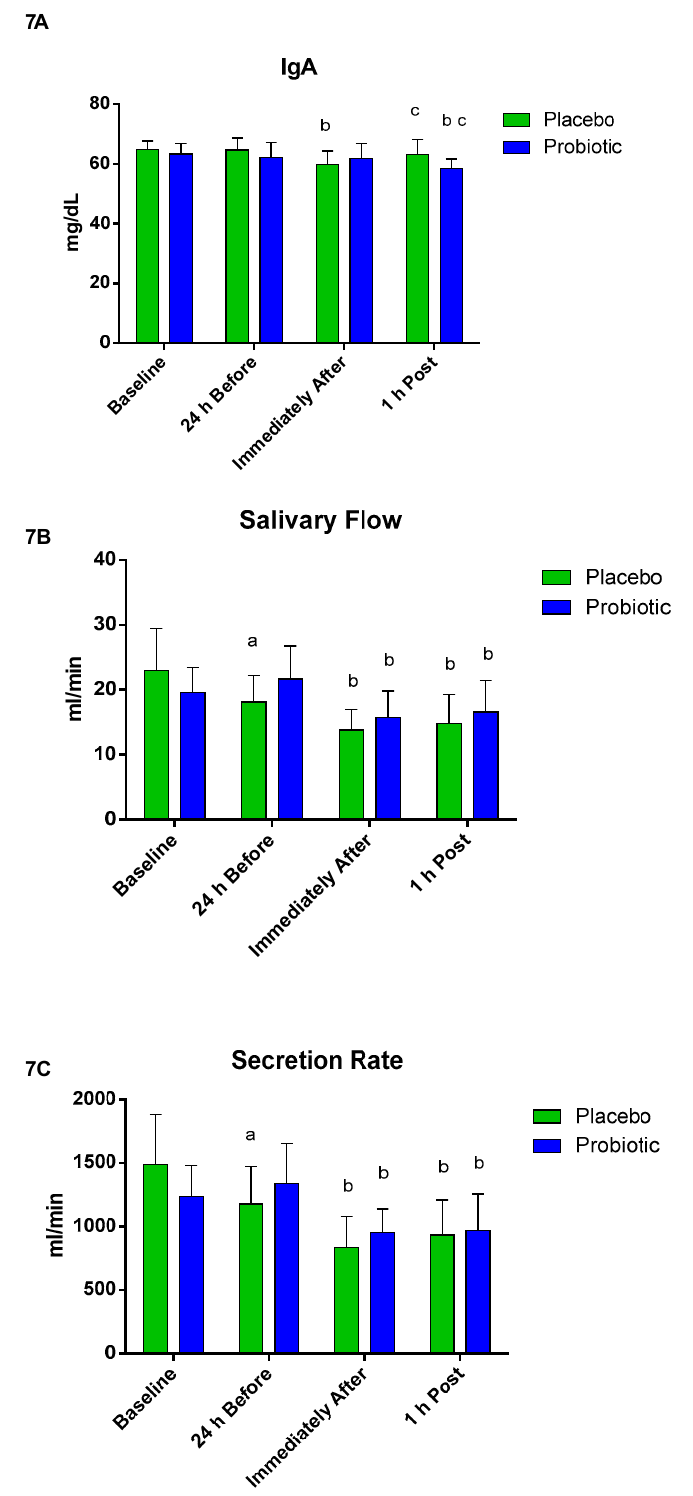
Figure 7. Salivary parameters. Data presented as mean ± standard deviation. Placebo ( n = 7) and probiotic ( n = 7). The comparison between groups and moments was performed through the general linear model (GLM) with post hoc Tukey. ( A ) IgA concentration. ( B ) Salivary flow. ( C ) Secretion rate. a: differs from ‘Baseline’ of the same group. b: differs from the ‘24 h Before’ of the same group. c: differs from the ‘Immediately After’ of the same group.